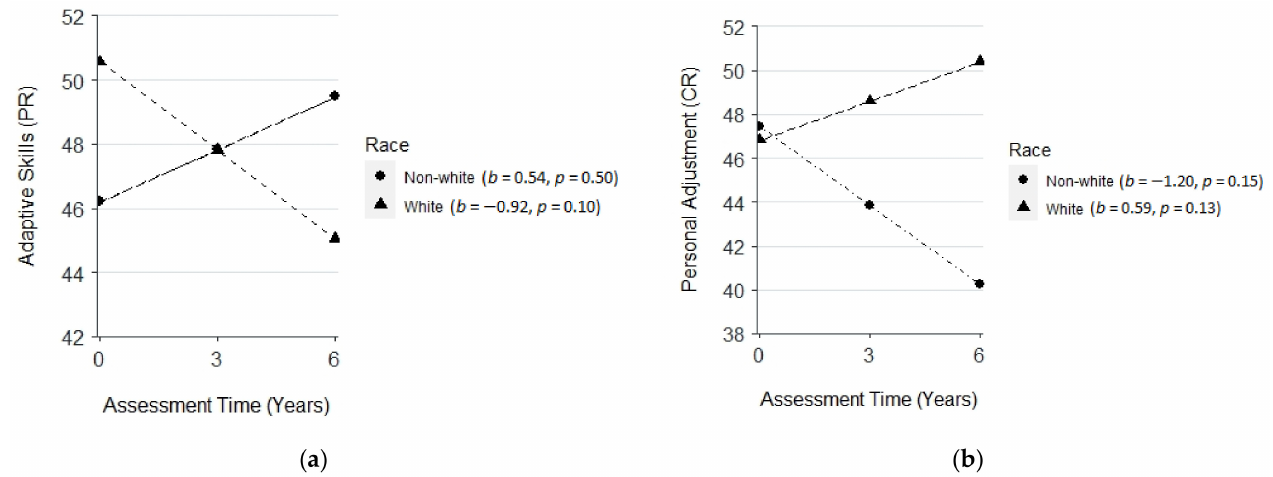
Figure 3. ( a ) plot for the interaction effect among assessment time and race on adaptive skills (parent-reported, PR); ( b ) plot for the interaction effect among assessment time and race on personal adjustment (child-reported, CR).